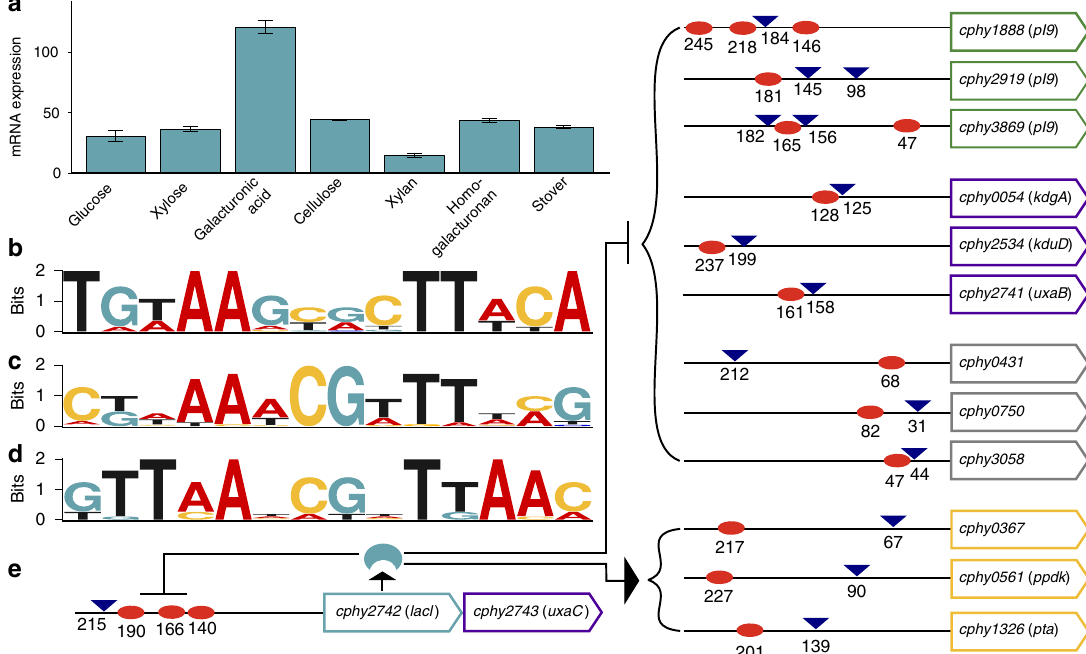
Figure 5 | The role of the LacI/GalR regulator Cphy2742 in galacturonic acid and pectin metabolism. ( a ) Transcription of the LacI/GalR gene cphy2742 is up-regulated on galacturonic acid relative to other carbon sources. Bars shows average RNA-seq RPKM of duplicate cultures; error bars are one s.d. ( b – d ) Upstream palindromes resembling cre operator sites found upstream of C. phytofermentans LacI/GalR genes and their orthologs from related genomes ( b ) cphy2742 (motif e ¼ 1.1 (cid:3) 10 (cid:2) 8 ), ( c ) cphy2467 (motif e ¼ 2.4 (cid:3) 10 (cid:2) 8 ) and ( d ) cphy1883 (motif e ¼ 8.9 (cid:3) 10 (cid:2) 2 ). ( e ) Twelve genes have both TSS (blue triangles) and putative Cphy2742 operators (red ovals) including genes for pectin lyases (green), galacturonic acid metabolism (purple), general carbon metabolism (yellow) and other or unknown (grey). The distance from the translation start is shown for each site.